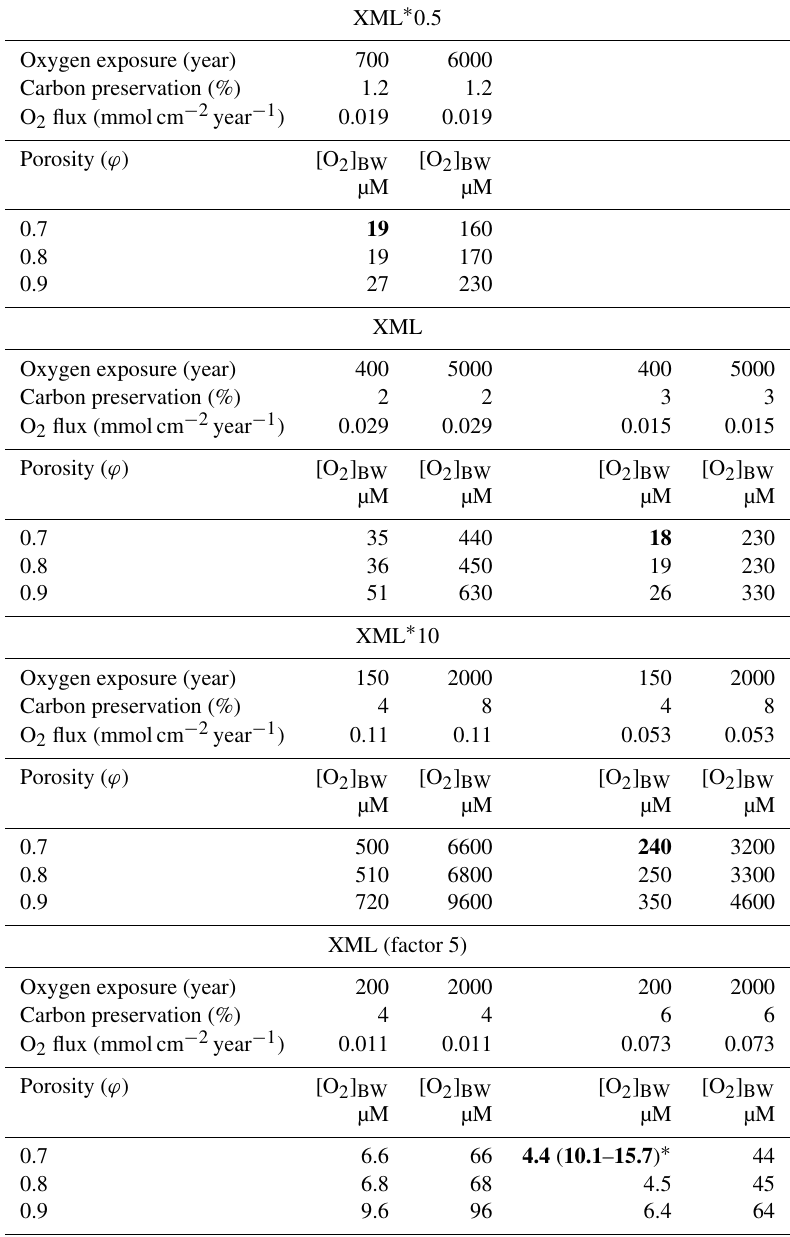
Table 4. Calculations of [O 2 ] BW (µM) for our different assumptions of sedimentation rate (lowest value for each sedimentation rate in bold). XML ∗